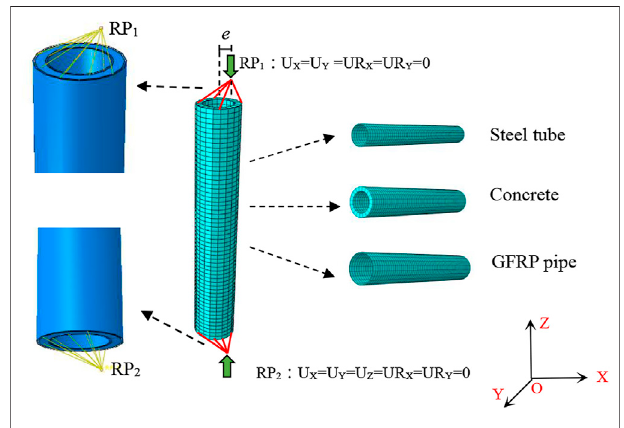
FIGURE 6 | Meshing of fi nite element model.